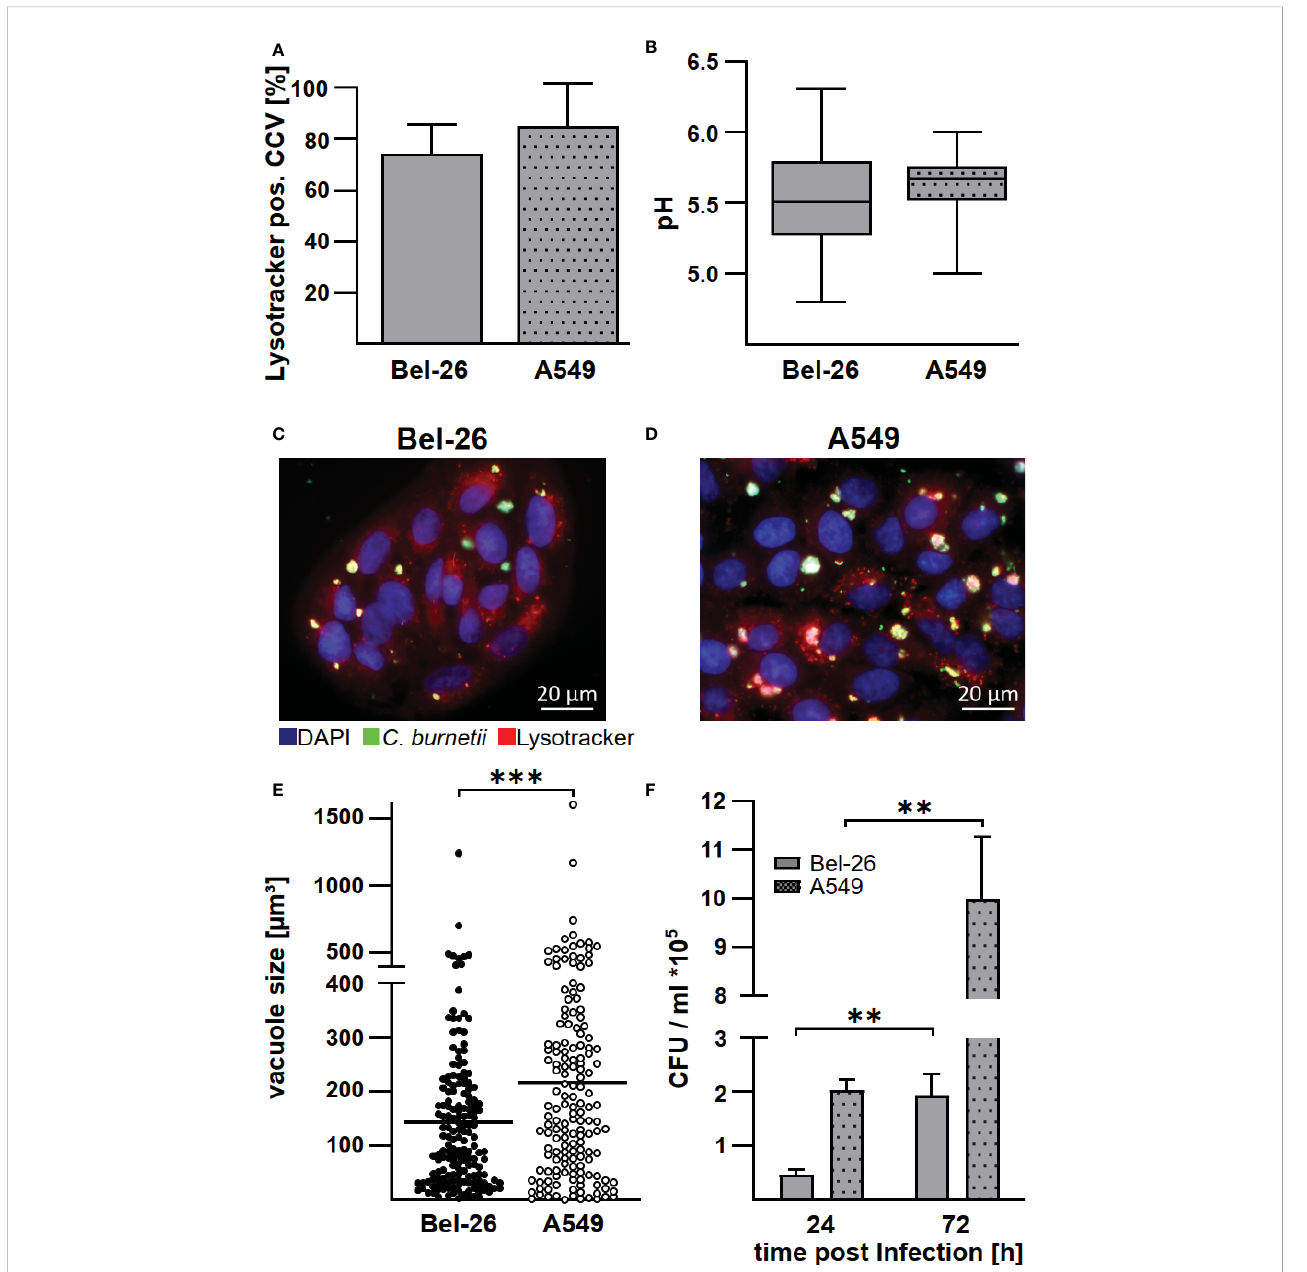
FIGURE 1 C. burnetii replicate in bovine and human lung epithelial cell lines in a lysosome-like compartment. The bovine lung epithelial cell line Bel-26 and the human lung epithelial cell line A549 were infected with C . burnetii NMII. (A) At 47 h post-infection, 1µM LysoTracker Red DND-99 was added to the culture medium for 1h. The cells were fi xed, permeabilized and stained with an anti- C. burnetii antibody and DAPI. The percentage of LysoTracker positive C. burnetii -containing vacuoles (CCVs) of 100 infected cells in each of three independent experiments was determined. Mean ± SD. (B) The pH of the CCVs at 48 h post-infection was determined by calculation of the fl uorescence intensity ratios of the dual-wavelength fl uorophore LysoSensor Yellow/Blue DND-160. Data represents average values ± SD of 50 infected cells per sample from three independent experiments. (C, D) Representative immuno fl uorescence micrographs of (C) Bel-26 and (D) A549 cells infected with C. burnetii NMII for 48 h using a ApoTome (Zeiss). (E) The dimension of CCVs at 72 h post-infection was determined from confocal Z-stack images using the the LSM700 microscope and Zen (Zeiss) software. The volume of at least 100 CCVs from two independent experiments are shown. An unpaired t-test was performed. ***p < 0.001. (F) C. burnetii counts of either infected Bel-26 or A549 cells were determined at the time points indicated via counting of colony forming units (CFU). Shown is a representative experiment out of three experiments with similar results, performed with technical triplicates of biological duplicates. Mean ± SD, n = 6, Mann-Whitney test.